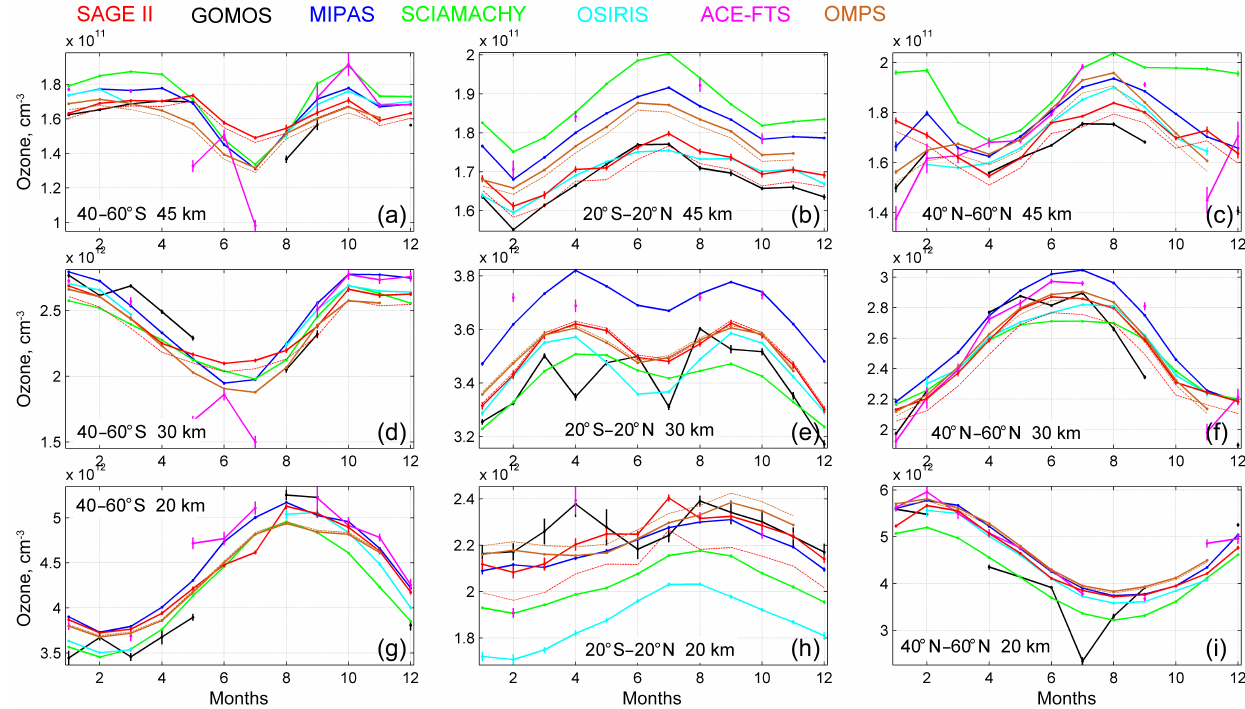
Figure 3. Ozone seasonal cycle for latitudes 40–60 ◦ S (a, d, g) , 20 ◦ S–20 ◦ N (b, e, h) and 40–60 ◦ N (c, f, i) , for altitudes 45km (a–c) , 30km (d–f) and 20km (g–i) . Error bars are 2 σ uncertainties according to Eq. (5). Dashed lines indicate corrected seasonal cycle for SAGE II and OMPS, see text for explanation. The seasonal cycles in the indicated zones are computed as the mean of seasonal cycles in 10 ◦ latitude